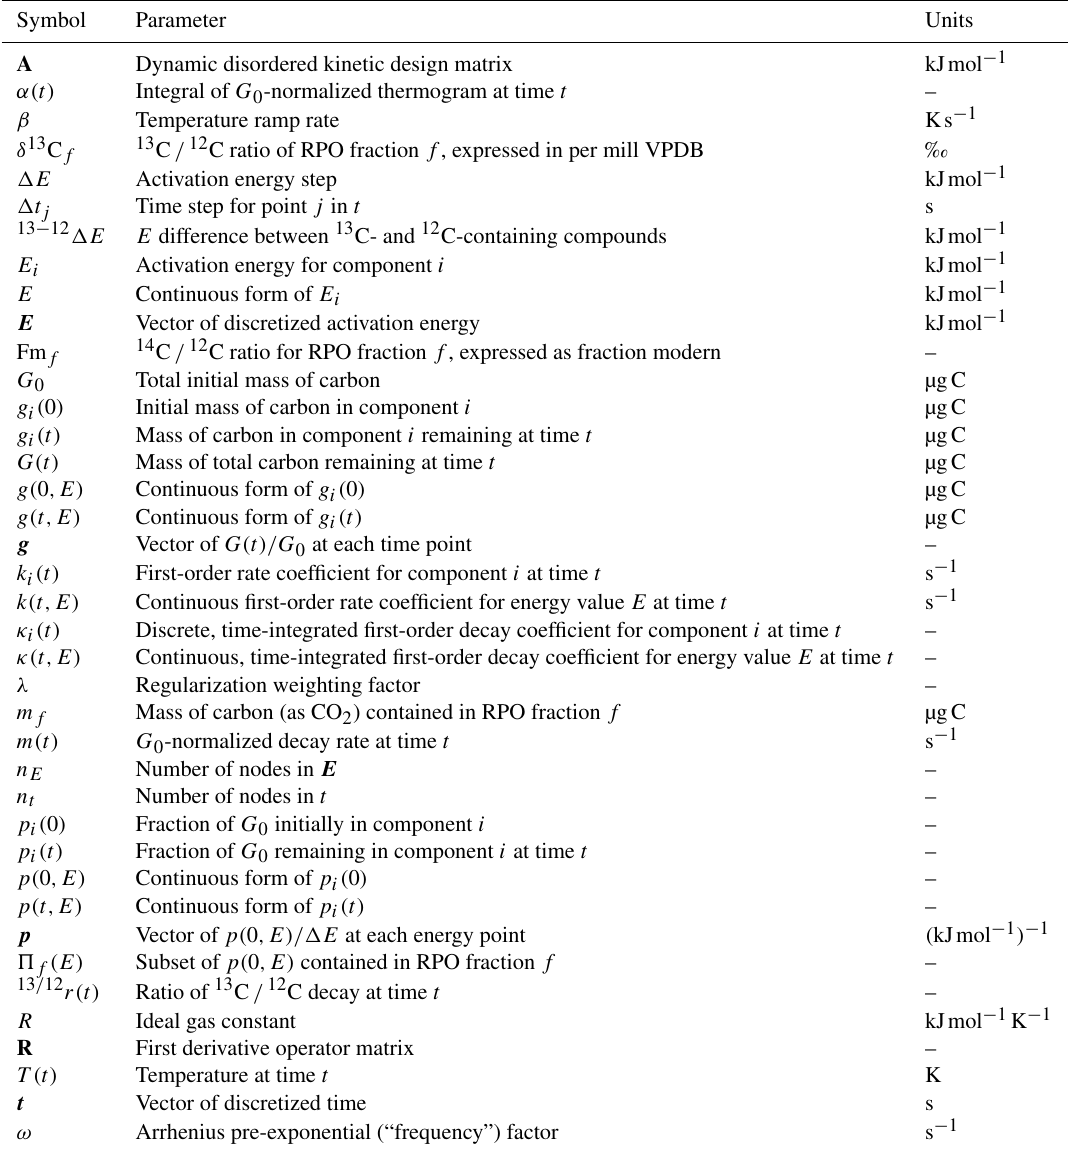
Table 1. List of mathematical symbols used throughout this study. Symbol Parameter Units A Dynamic disordered kinetic design matrix Integral of G 0 -normalized thermogram at time